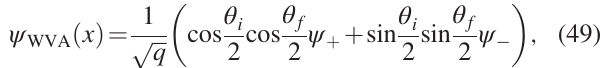
and θ . Two-dimensional slices through this three-dimensional i f θ 0 . The ; and when preselection is into an eigenstate of the control observable, θ i ¼ f i ¼ θ π = 2 ; f ¼ i þ π = 2 . The three-dimensional plot isosurfaces i ¼ P =F P (the color map is given in the legend); in the two-dimensional g ½ g ½ WVA (cid:2) std (cid:2) ∈ ½ 0 ; π (cid:2) with no i